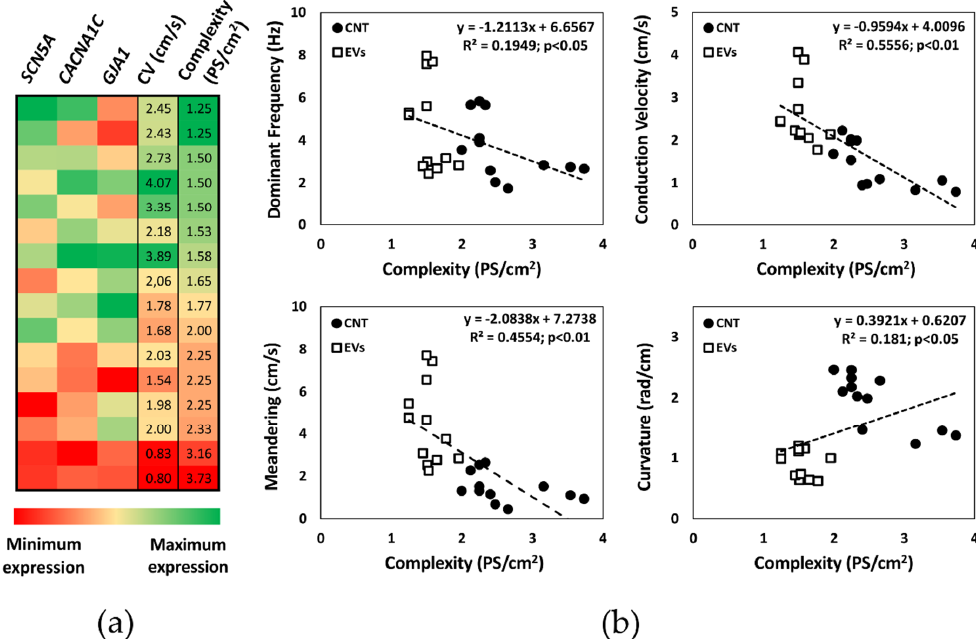
Figure 5. Relative gene expression relationship with CV and complexity, and relationship of the different electrophysiological parameters with activation complexity. ( a ) Relative gene expression of SCN5A , CACNA1C , and GJA1 in each sample and its associated CV and complexity. While SCN5A and CACNA1C higher expression correlated significantly with higher CV and lower complexity measurements, GJA1 expression did not. ( b ) Dominant frequency ( p < 0.05), CV ( p < 0.01), meandering ( p < 0.01), and curvature ( p < 0.05) correlated significantly to activation complexity.